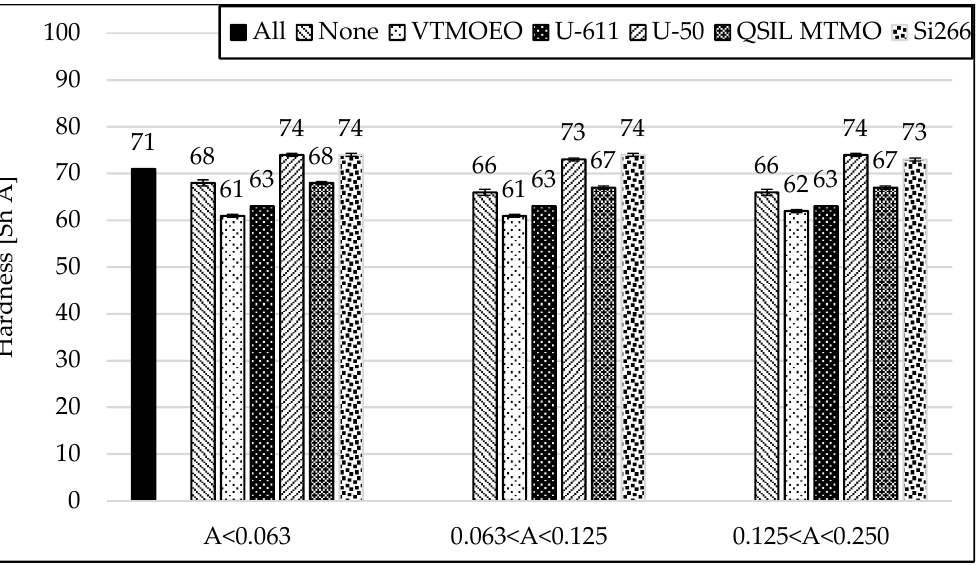
Figure 10. Influence of the silanization of fly ash with various silanes on hardness of the rubber vulcanizates filled with CB and different FA fractions. Table 7. Influence of the silanization of fly ash with various silanes on stress at elongation of 100%, 200%, and 300% of the rubber vulcanizates filled with CB and different FA fractions.